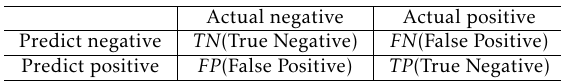
Table 2. Confusion Matrix for Binary Classification